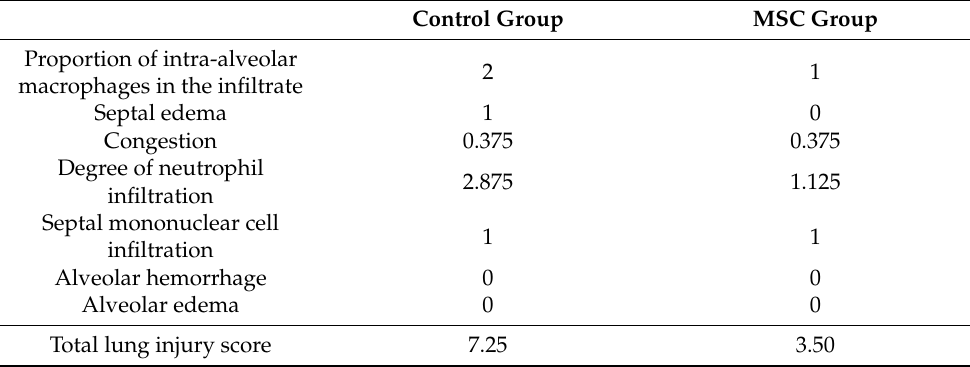
Figure 1. Characterization of UCMSCs. ( A ) In vitro culture, MSCs showed a spindle-shaped fi- broblastic morphology ( × 100). ( B ) Using flow cytometry, these cells were positive for CD73, CD90, and CD105, and negative for CD34, CD45, and CD14. ( C ) Under 2-week adipogenic induction, differentiation into adipocytes was achieved (Oil red O staining, × 100). ( D ) Under 2-week osteogenic induction, differentiation into osteocytes was achieved (von Kossa staining, × 100). Table 1. Average lung injury score for each estimated